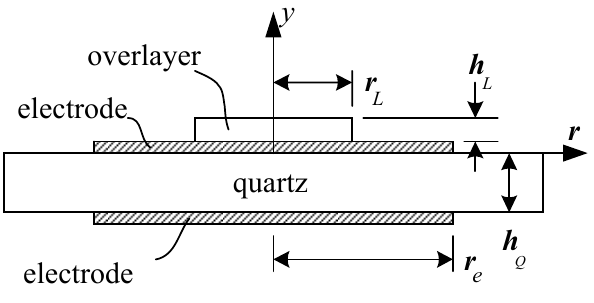
Figure 1. Sketch of a quartz crystal resonator with electrodes on both sides and a viscoelastic overlayer attached on the external surface of an